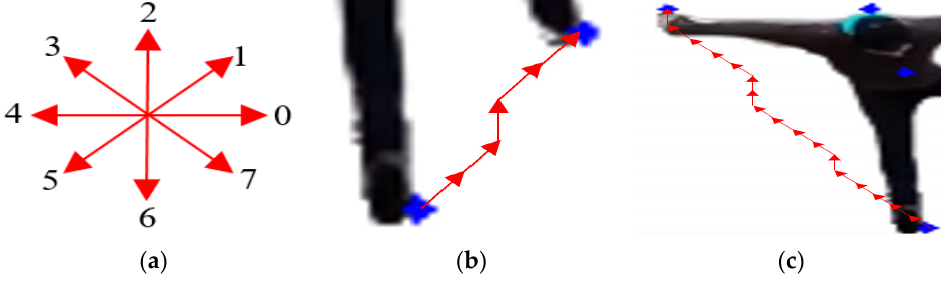
Figure 9. Freeman chain code feature showing ( a ) eight possible directions, ( b ) the chain code of a straight line between the right and the left foot, and ( c ) the chain code of a straight line between the right foot and the right hand.